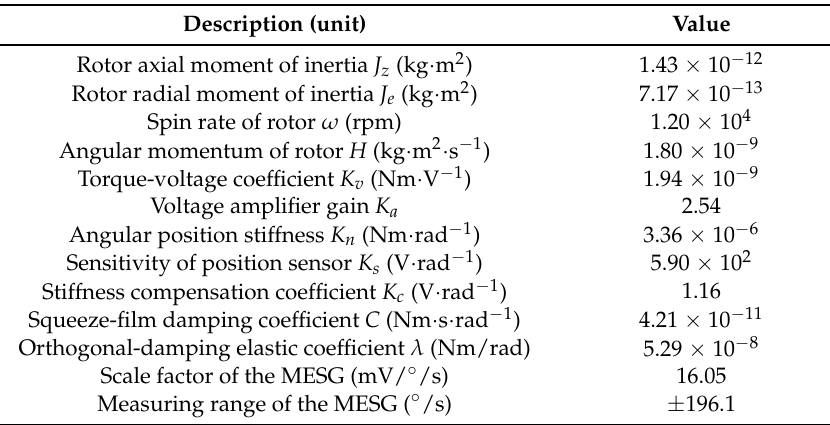
Table 1. Main parameters of the MESG rebalance loop.